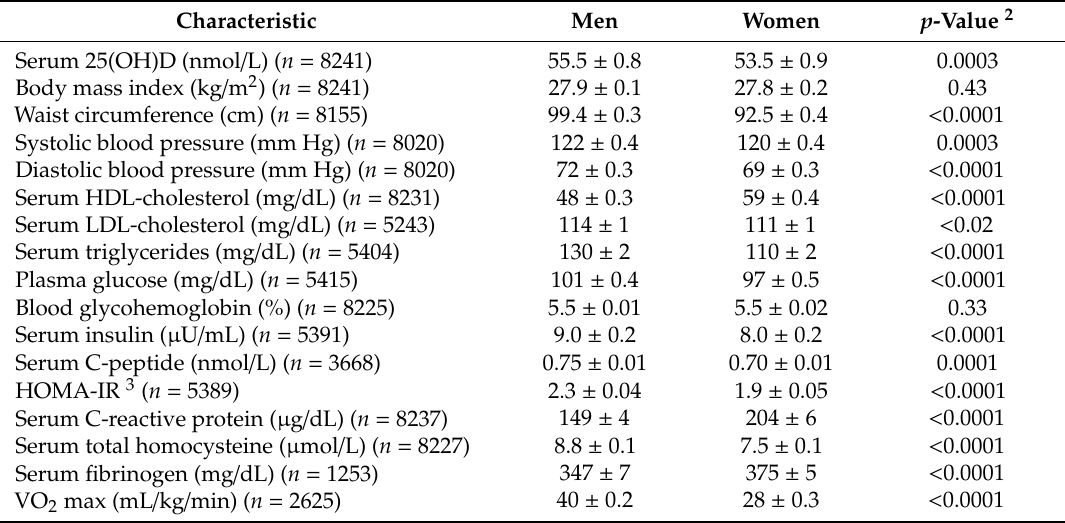
0.0003 53.5 ± 0.9 55.5 ± 0.8 0.43 27.8 ± 0.2 27.9 ± 0.1 < 0.0001 92.5 ± 0.4 99.4 ± 0.3 122 ± 0.4 120 ± 0.4 0.0003 < 0.0001 72 ± 0.3 48 ± 0.3 101 ± 0.4 0.33 9.0 ± 0.2 2.3 ±